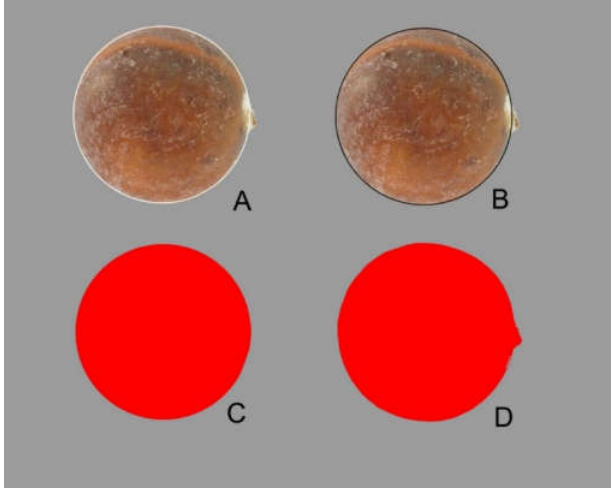
Figure 3. View of a seed of Geonoma congesta . ( A ) With white circle superimposed; ( B ) with a black circle superimposed; ( C ) The area shared (S) between the seed image and the geometric model for calculation with Image J. ( D ) Total area (T) for calculation in Image J. J index is the ratio S/T × 100. In this example, J index = 96.1. Image of G. congesta courtesy of Steven Paton. Taken from https: // stricollections.org /